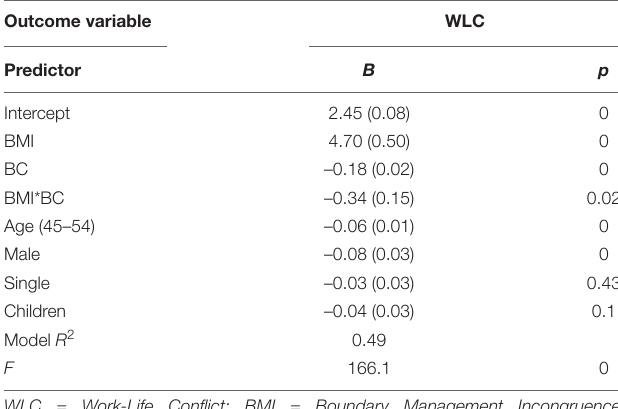
Boundary Control as a